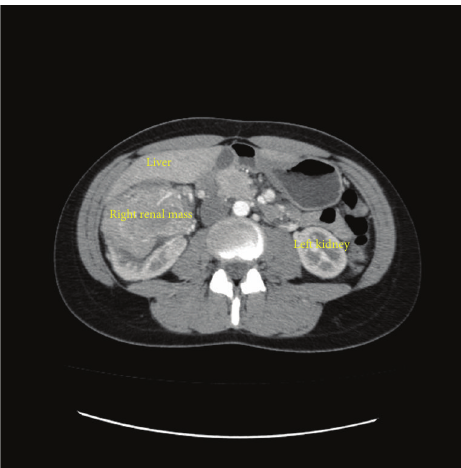
Figure 1: Axial images of computed tomography scan showing 9cm right upper pole mass.